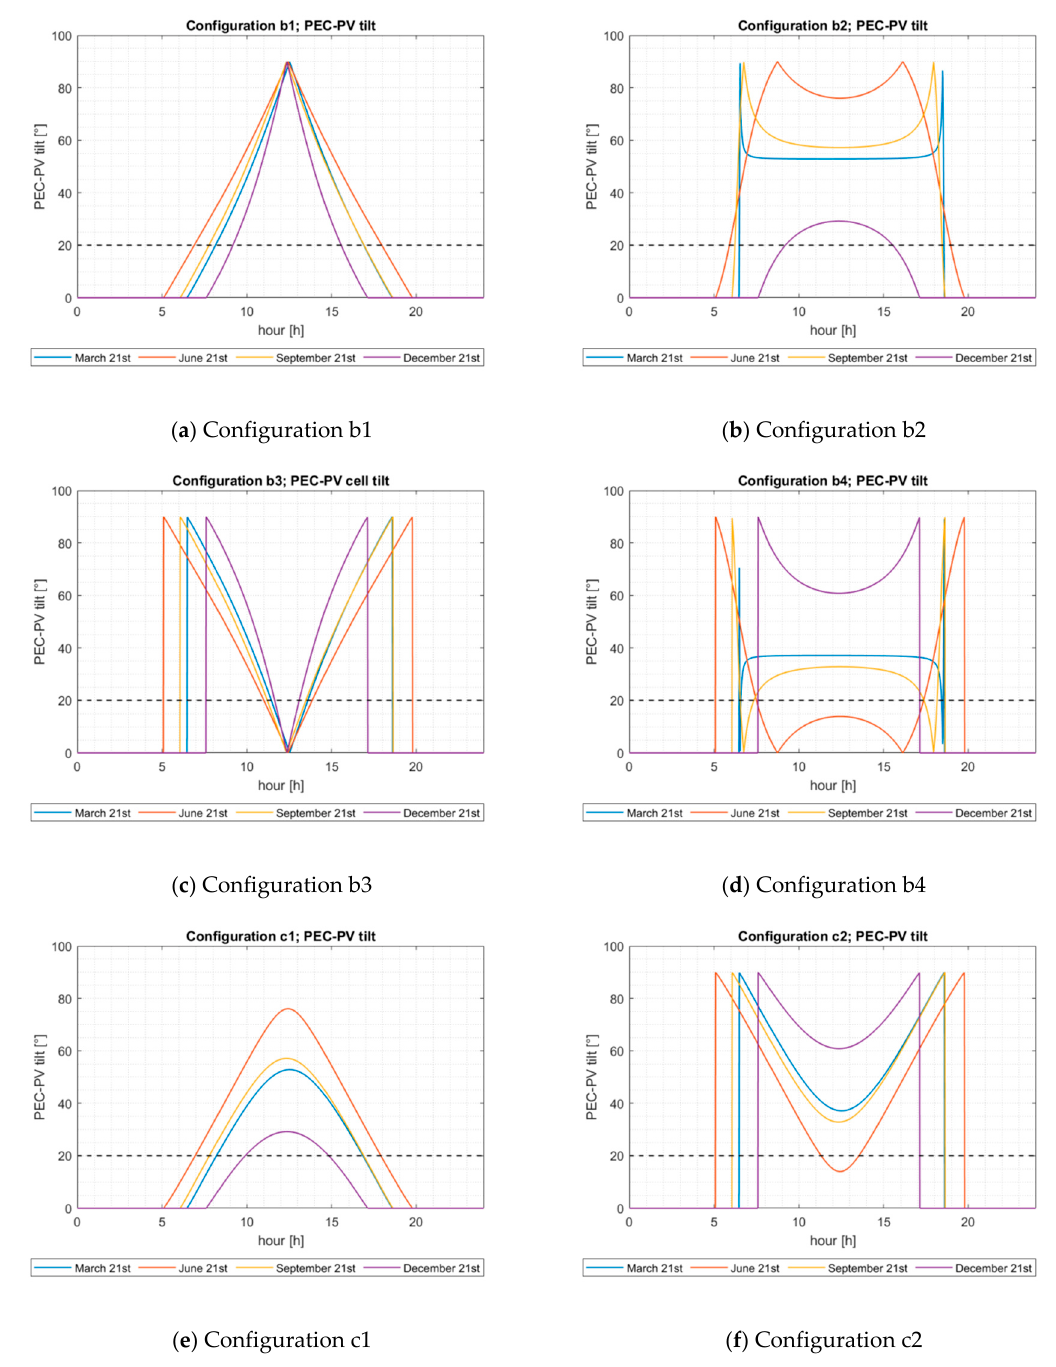
Figure A7. Intra-day PEC-PV tilt distributions on solstices and equinoxes for all geometrical configurations (except a1 and a2) without applying tilt constraints. The lower tilt threshold (20°) is represented as a black dotted line. Site: Seville, Spain.